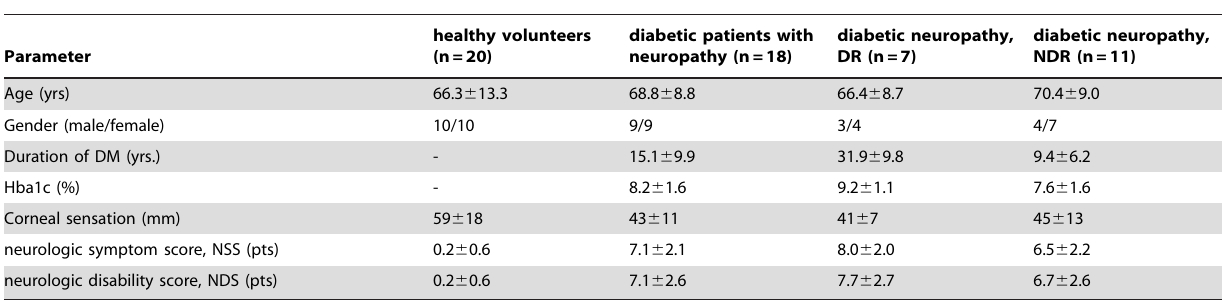
Table 1. Clinical and demographic data of participants (data presented as mean 6 SD).